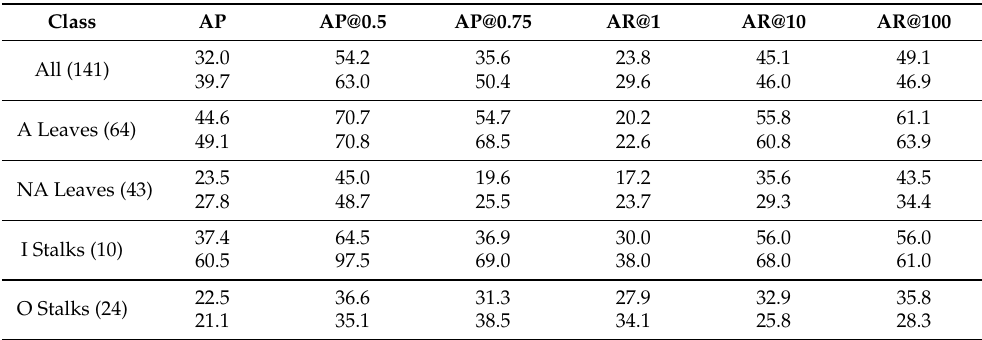
Table 7. Results on a test set with consistent annotations from the one annotator. For each metric, results from two models are shown trained on different sets of data, the upper being trained on the inconsistent dataset and the lower being trained on the consistent